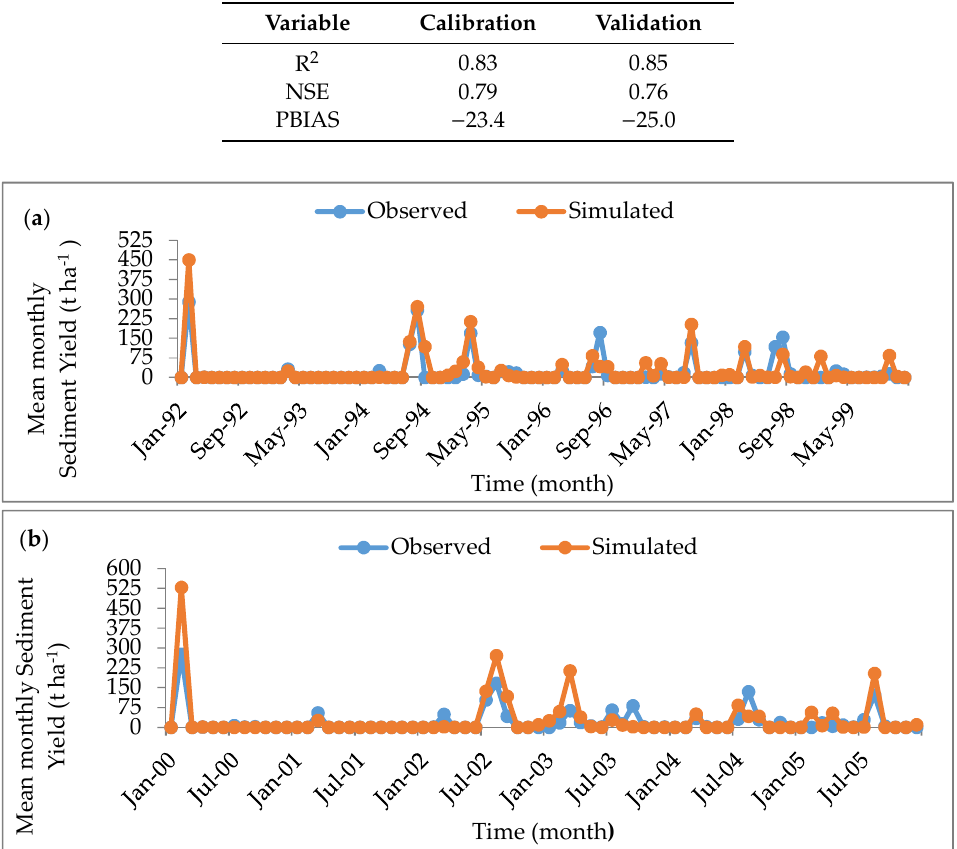
Table 7. Monthly sediment yield calibration and validation results at the Logiya outlet gauging